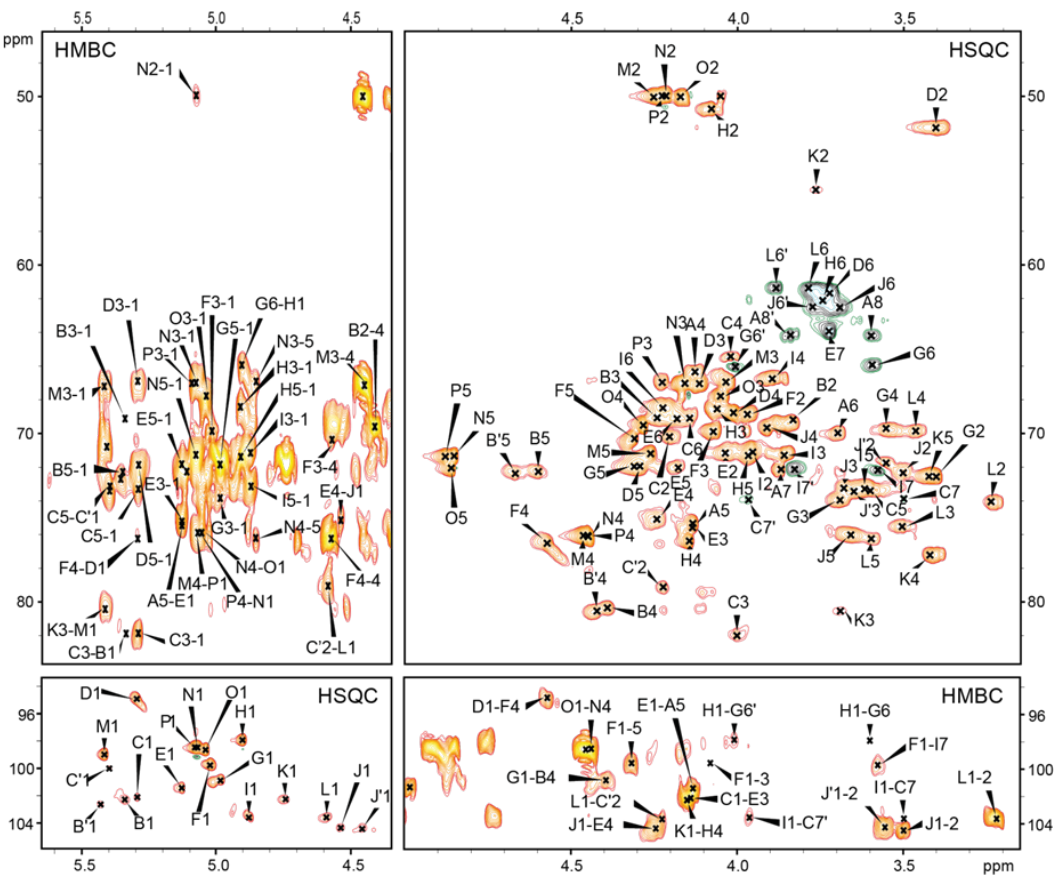
Figure 2. Selected regions of 1 H, 13 C HSQC-DEPT and HMBC spectra of the OSRU. The capital letters refer to carbohydrate residues, as shown in Figure 1 and Table 1. The Arabic numerals refer to protons and carbons in respective residues. Letter C with a prime sign denotes residues → 2,3,7)- L -α- D -Hep p -(1 → instead of the → 3,7)- L -α- D -Hep p -(1 → (C residue). Residues B’ and J’ are variants of residues B and J respectively, present in the core OS containing t-Glc (L residue).